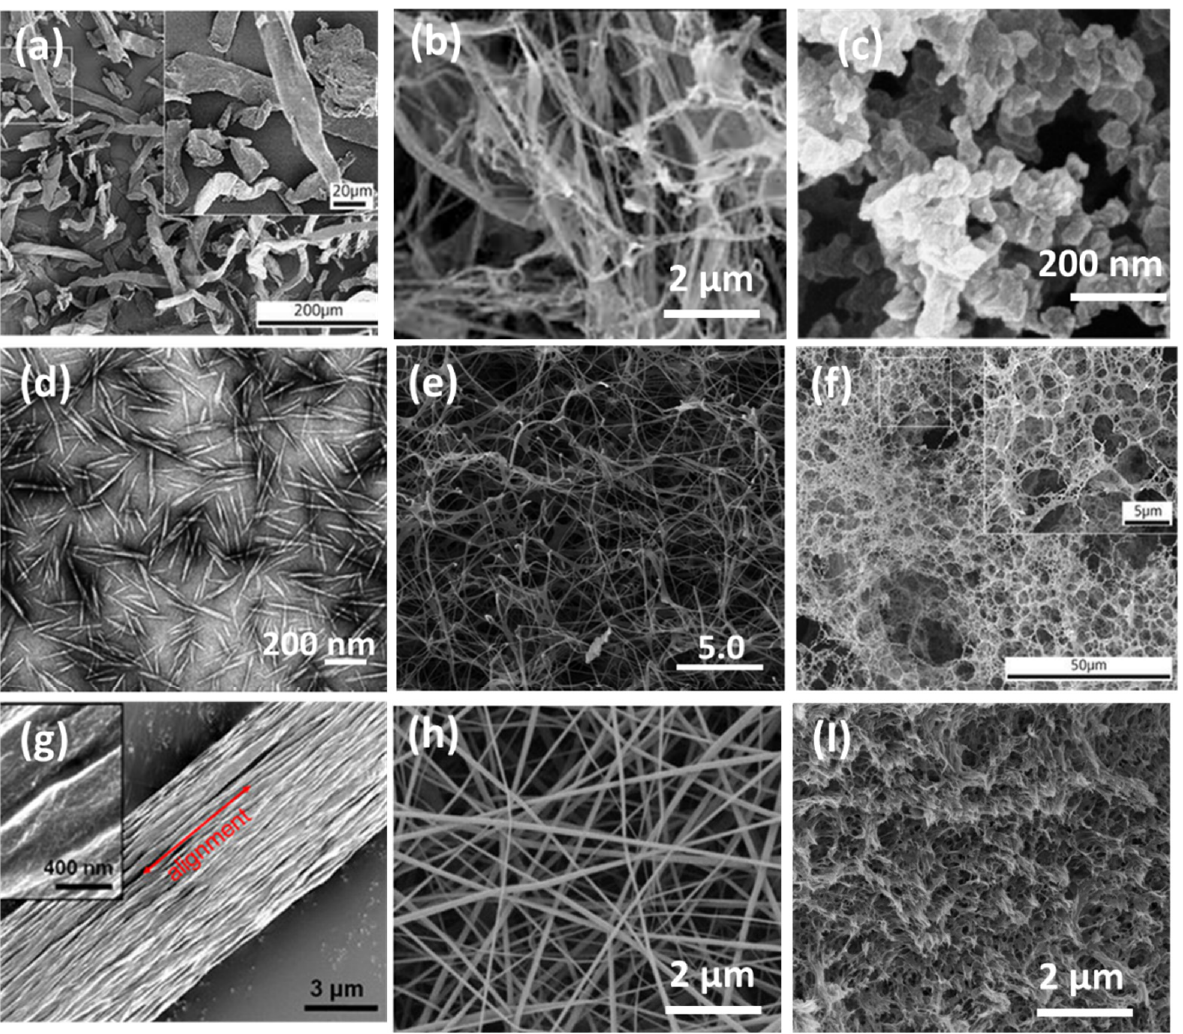
Figure 1. Electron microscope micrographs of different types of cellulose nanomaterials: ( a ) cellulose microfibers (CMFs) [21], © Springer Nature, 2021; ( b ) Cellulose fibers (CNFs) [22], © Hindawi, 2017; ( c ) Spherical cellulose nanoparticles (SCNPs) [23], © Elsevier, 2007; ( d ) Cellulose nanocrystals (CNCs) [24], © MDPI, 2008; ( e ) cellulose nanofibers (CNFs) [25], © Royal Society of Chemistry, 2009; ( f ) bacterial cellulose (BC); ( g ) cellulose nanofibers assembled into a material stronger than spider silk [26], © American Chemical Society, 2018; ( h ) Electrospun cellulose nanofibers (CNFs) [27], © Elsevier, 2014; ( i ) Cellulose aerogels [28], © MDPI, 2018.